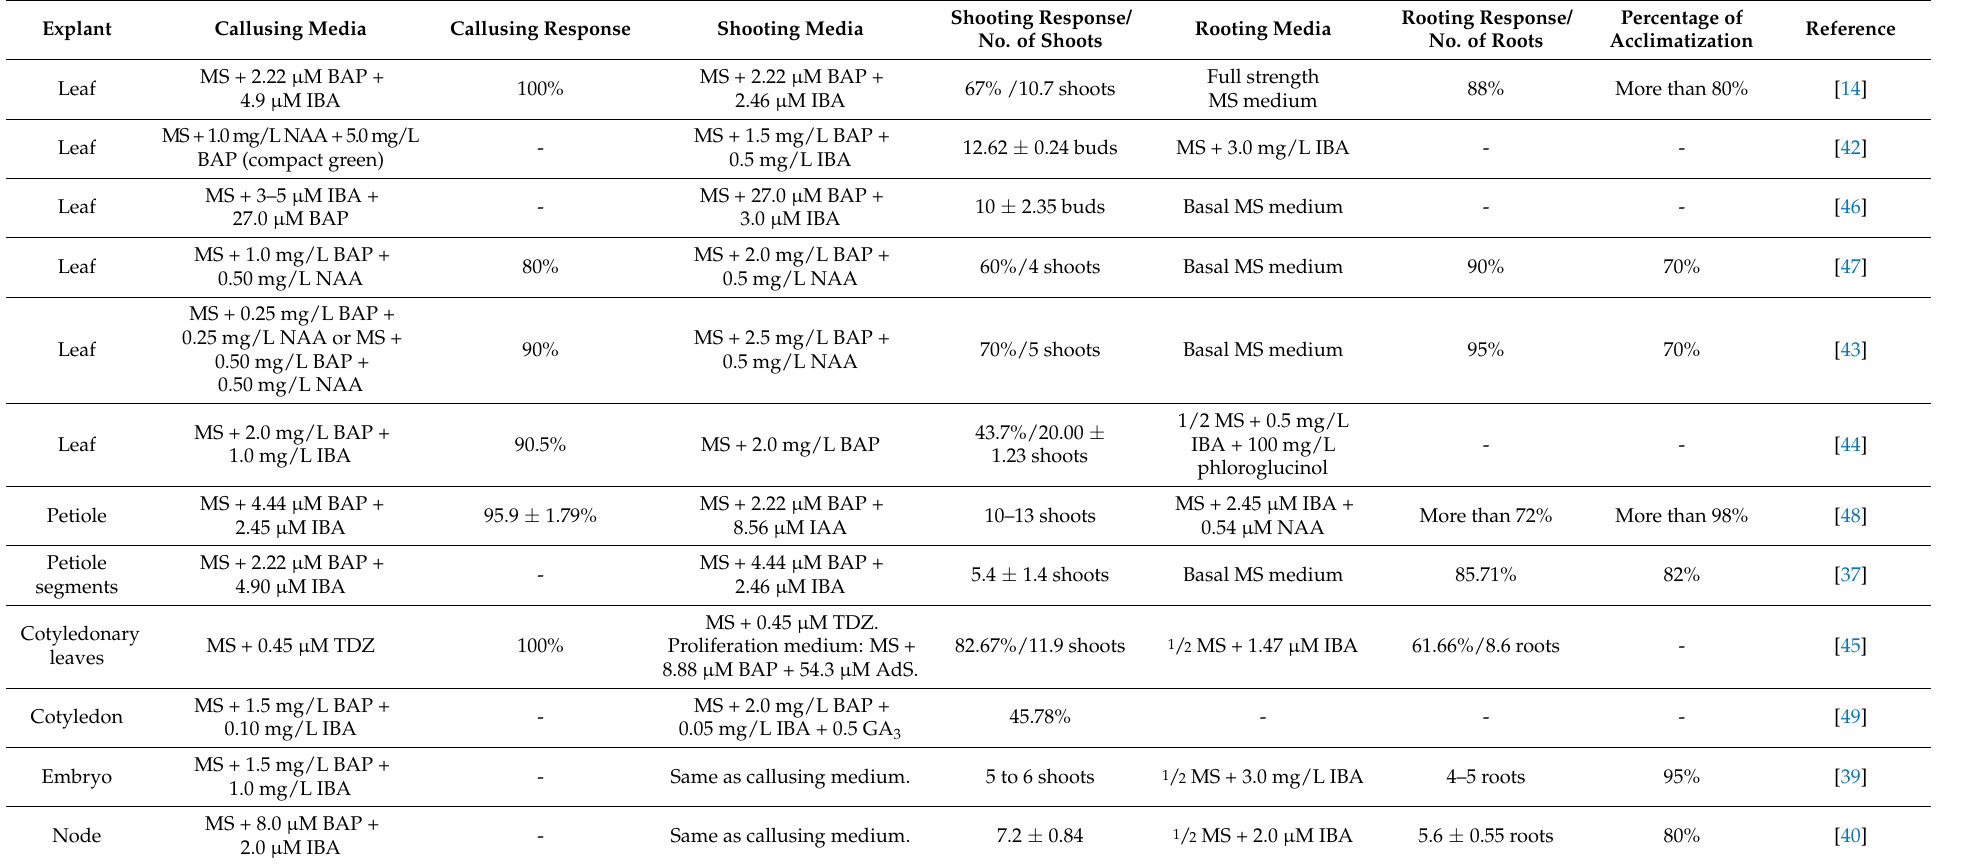
Table 2. Indirect organogenesis from various explants of Jatropha curcas